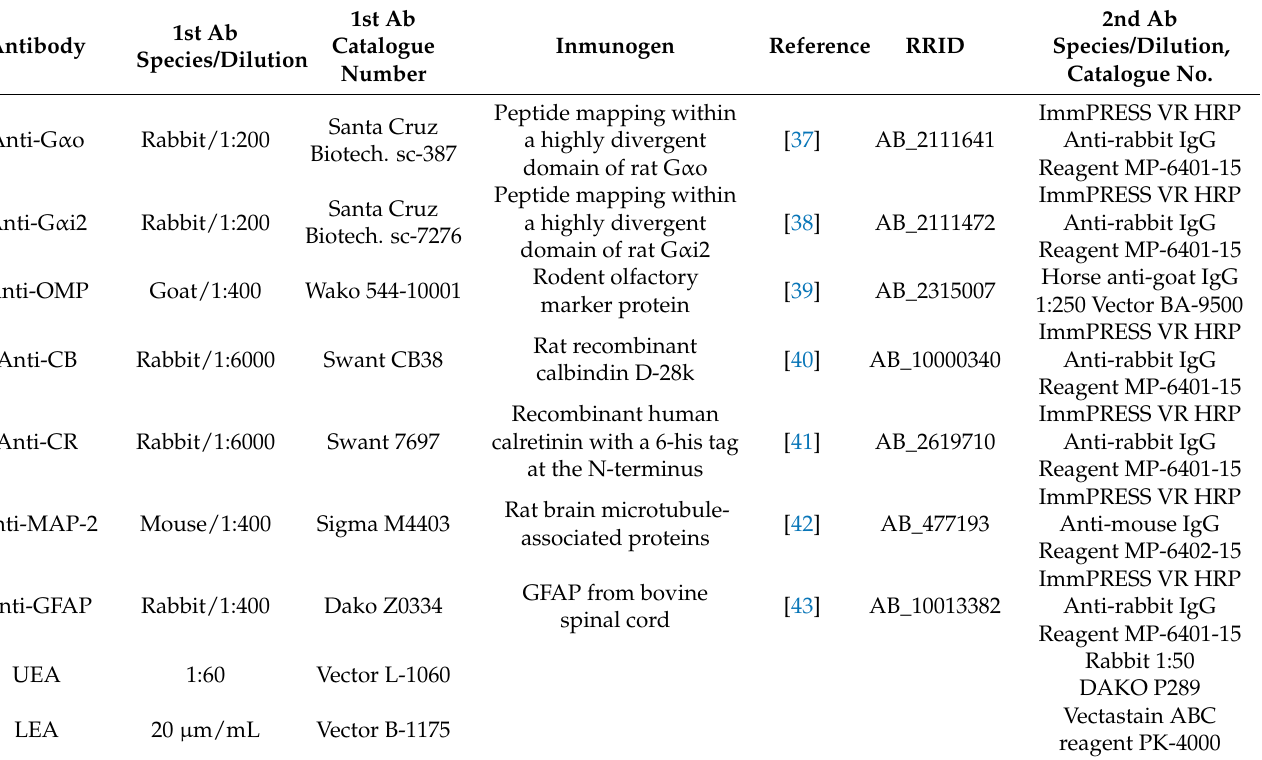
Table 1. Antibodies and lectins used, species of elaboration, dilution, catalogue number, manufacturer, target immunogens and relevant reference for each antibody, and RRID